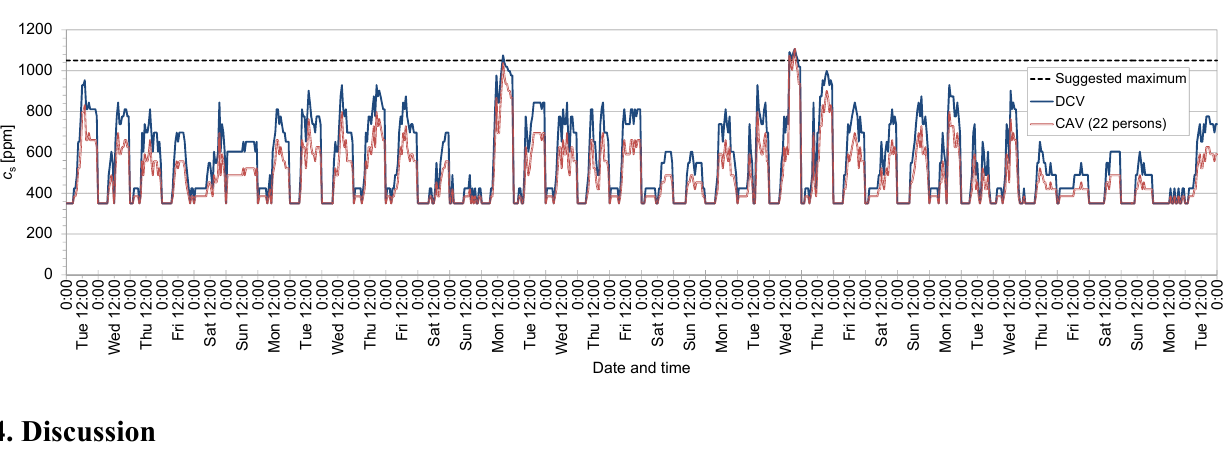
concentrations ( c ) in the Café room using the 2 s concentration 2